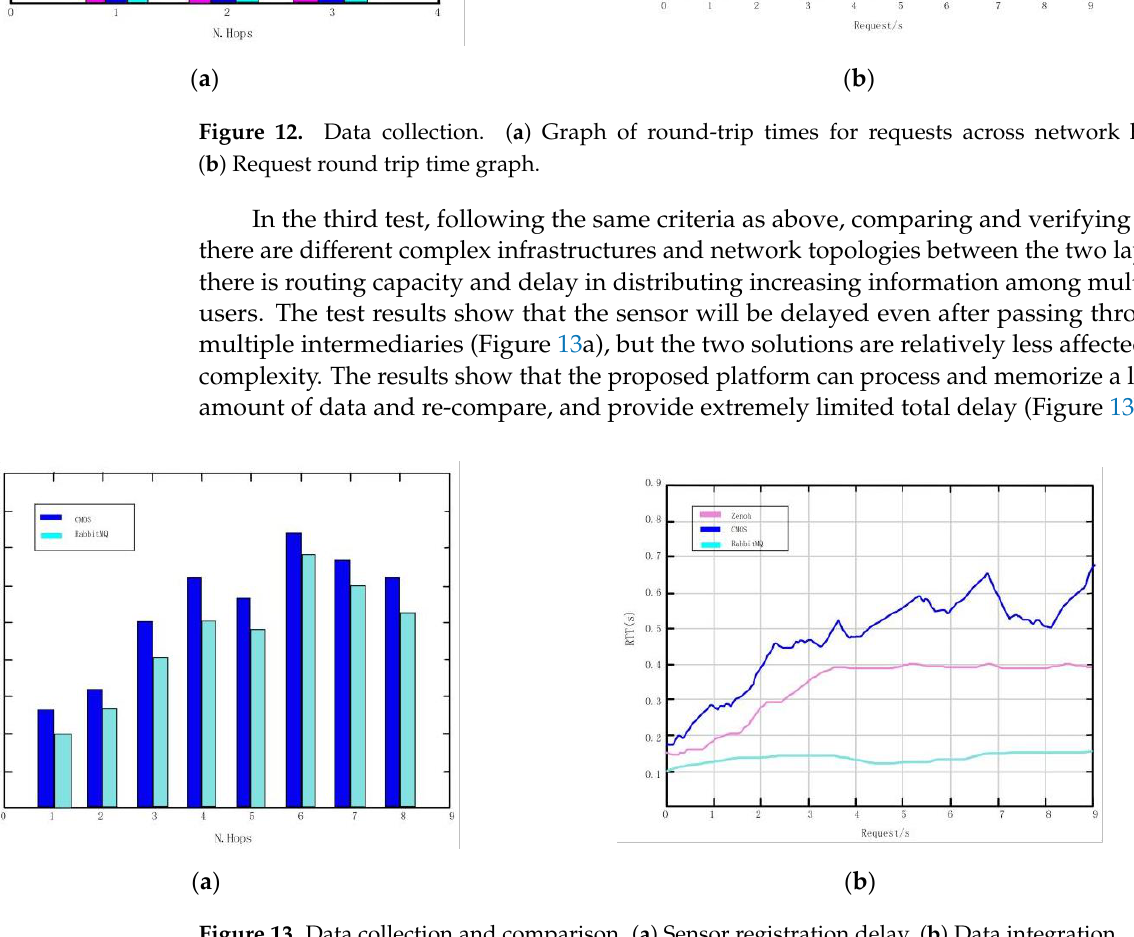
Figure 13. Data collection and comparison . ( a ) Sensor registration delay. ( b ) Data integration.